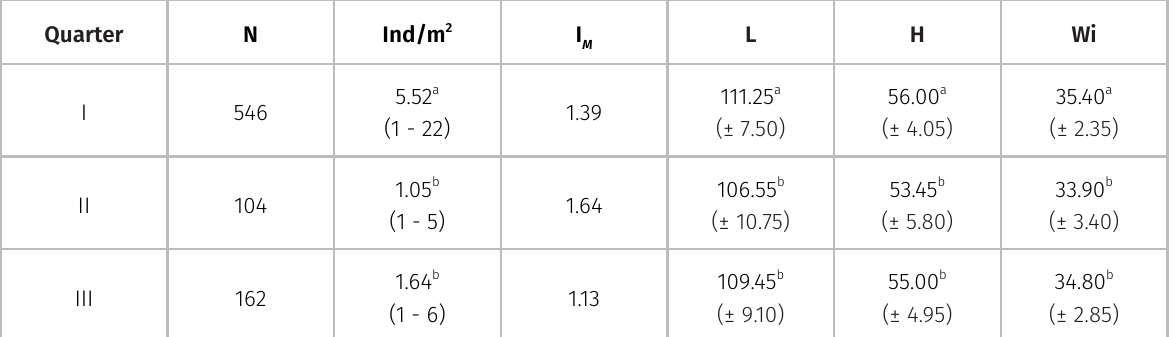
Table II. Total number of shells (N), mean, minimum and maximum density (Ind/m 2 ), distribution pattern (I and mean (± standard deviation) values of the analyzed biometric variables for the dead valves of Anodontites trapesialis at the three quarters analyzed.